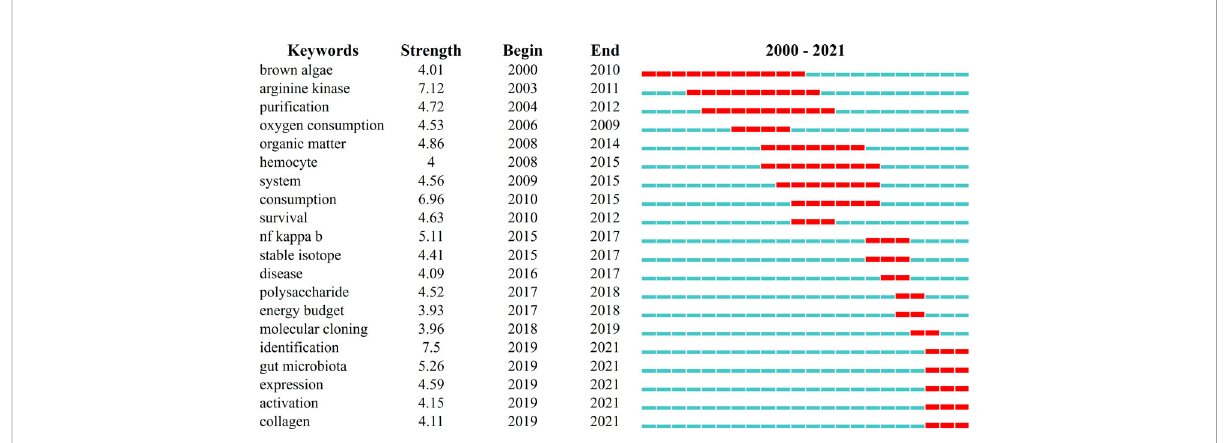
FIGURE 5 The emergence map of the top 20 keywords in the fi eld of Apostichopus japonicus from 2000 to